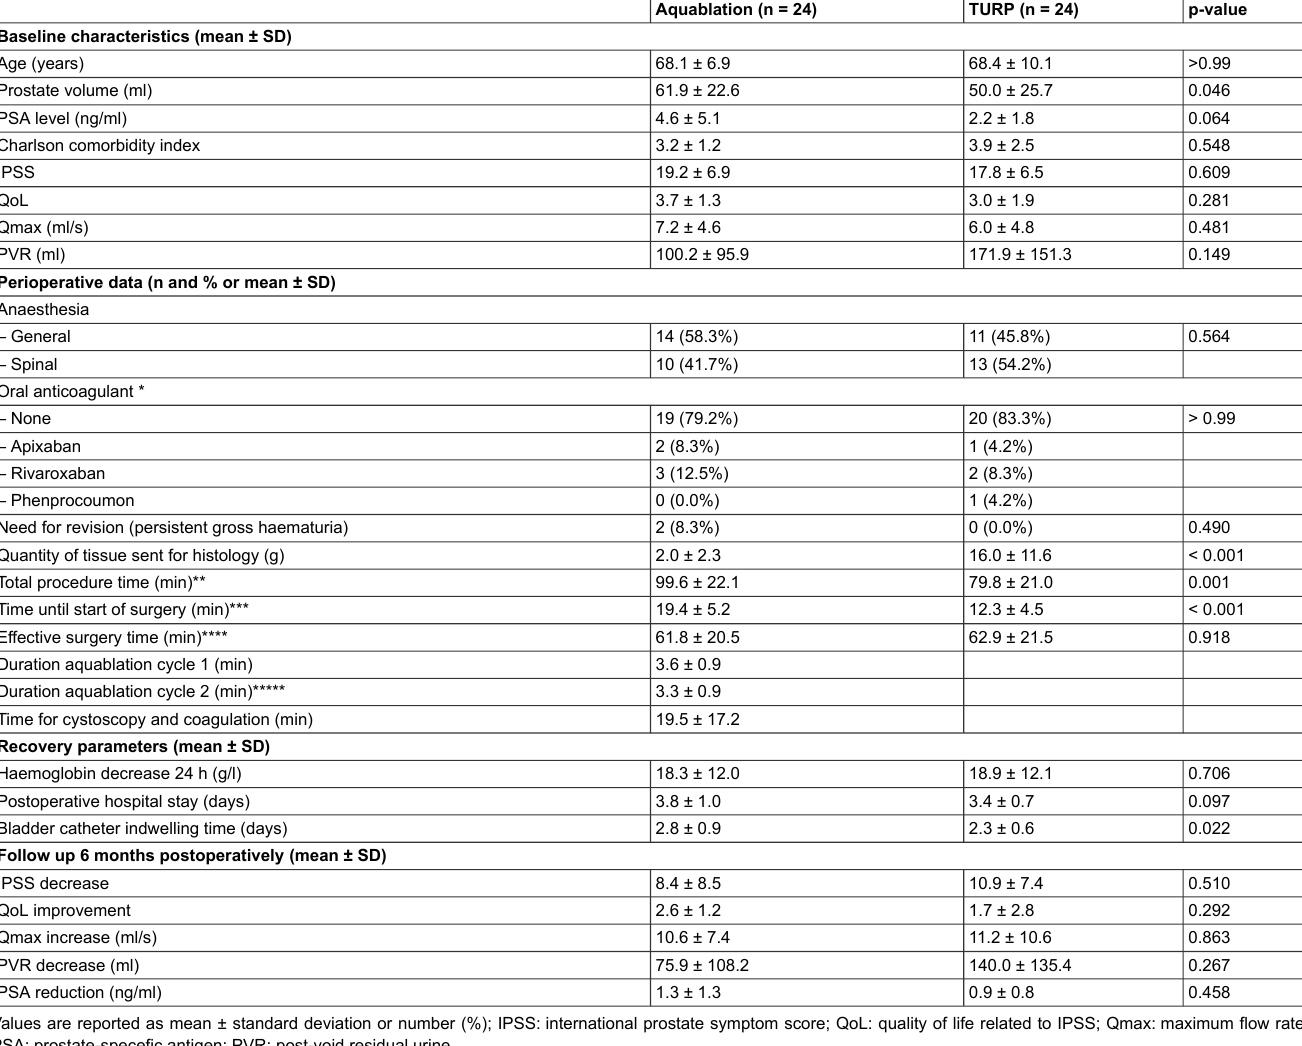
Table 1: Patient characteristics, procedural details and postoperative results by treatment group, with p-values from Wilcoxon rank sum tests or Fisher's exact tests for differences be- tween